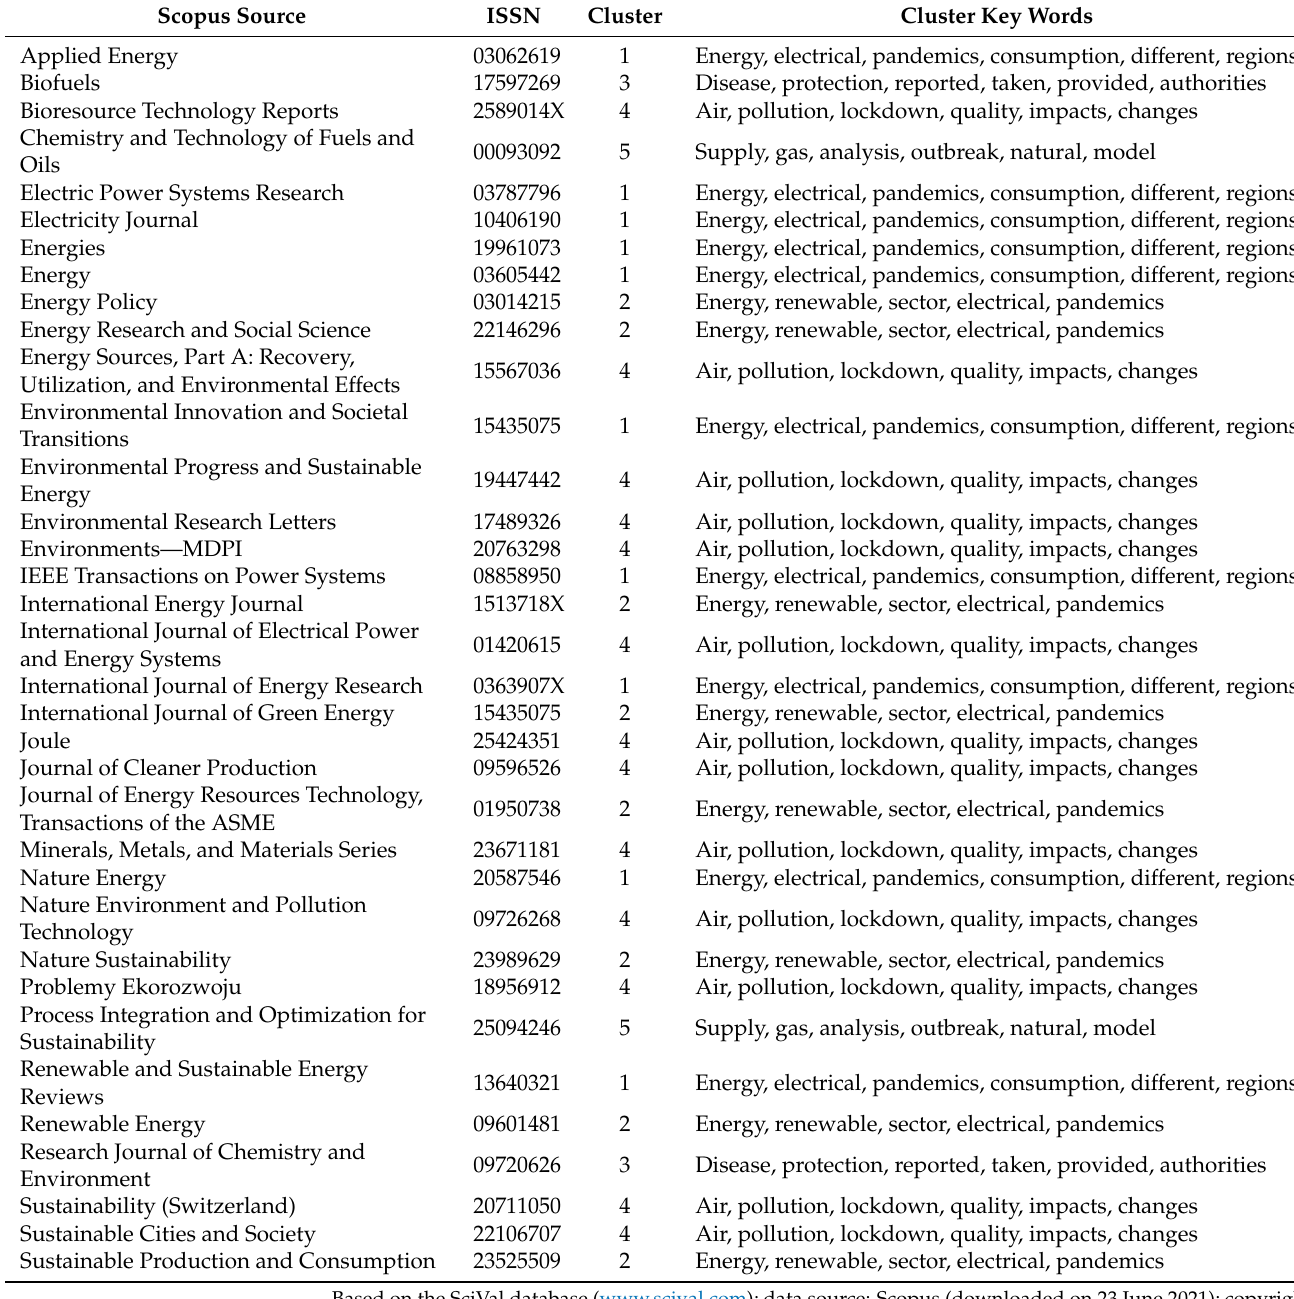
Table A1. The cluster analysis results of journal annotations within energy (subject area renewable energy, sustainability, and the environment),